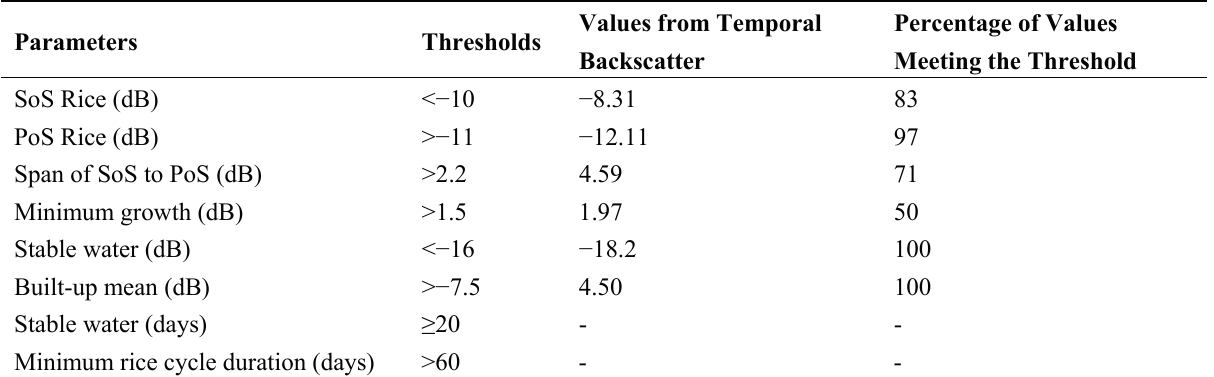
Table 6. Thresholds selected for rice identification and flooding/transplanting dates using TSX multitemporal